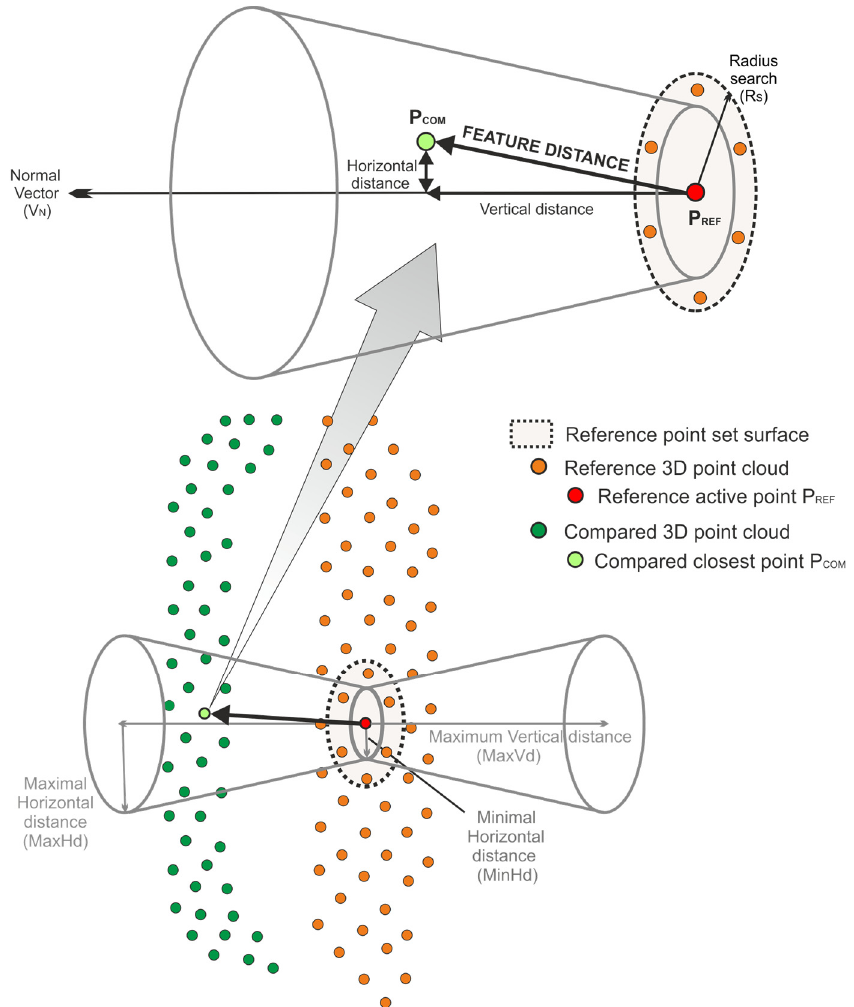
Figure 2. Depiction of the M3C2 adaption algorithm. From each point of the reference 3D point cloud, a normal vector (V N ) is computed with the neighboring points in a user defined search radius (Rs). The normal vector (V N ) defines the direction in which the closest point is sought (P COM ) in the compared 3D point cloud. The maximum and minimum horizontal distance and maximal vertical distances (MaxHd, MinHd, and MaxVd) are parameters assigned by the user to define a double truncated cone (for inward or outward searches). Table 1. Summary of the new features computed with the adaptation of the M3C2 [18] algorithm implemented in PCM software. Comparison between the distances of the 3D point clouds is per- formed in the direction defined by the reference normal vectors. Results are associated with a new point cloud with these features.